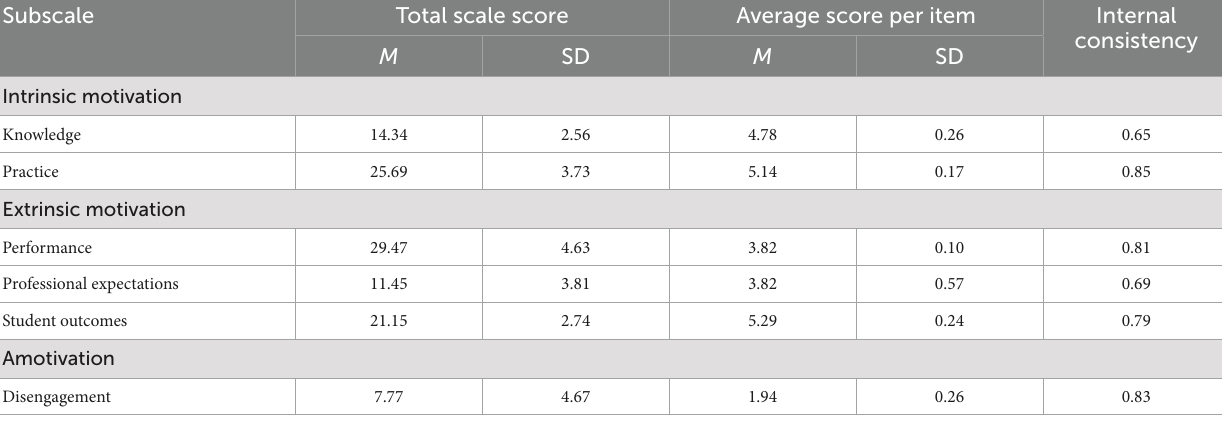
TABLE 2 Descriptive statistics and internal consistency coefficients for the motivation subscales.